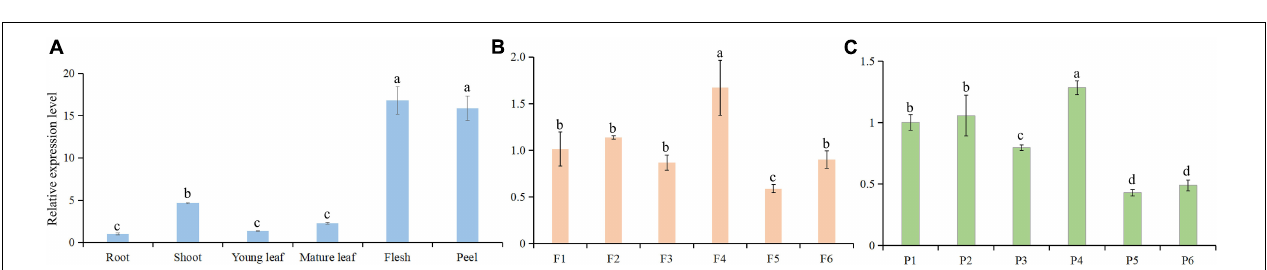
FIGURE 6 | Relative expression levels of FcTTG1 in different tissues and at different developmental stages in Ficus carica . (A) Fig plant tissues; flesh and peel are from ripe fruit. (B) Fig fruit flesh at developmental stages 1–6 corresponding to Figure 3A . (C) Fig fruit peel at developmental stages 1–6 corresponding to Figure 3A . Relative expression levels are shown as mean ± SD from three replications. Different letters between bars indicate significant difference at p <